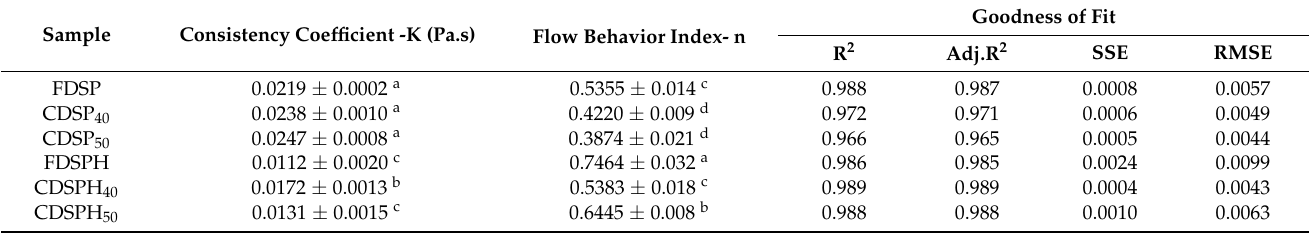
Table 2. Power law constants and goodness of fit for freeze- and convectively-dried SP and SPH. Sample Consistency Coefficient -K